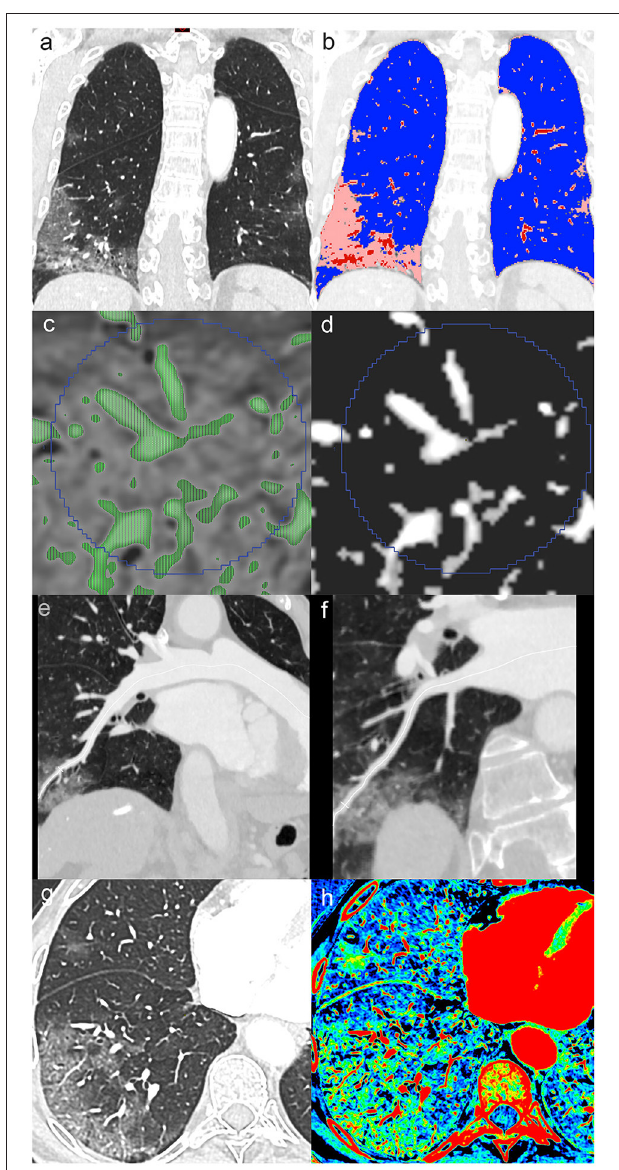
FIGURE 1 | Contrast-enhanced chest CT in a patient admitted for COVID-19. Coronal reformatted image (a) shows peripheral ground-glass opacity (GGO) predominantly involving the right lower lobe. Tissue classification (b) distinguishing alveolar opacity (peach color code) from normal parenchyma (blue) and vascular components (red) visually indicates vascular enlargement in COVID-19 pneumonia. Specific thresholds to isolate voxels, mostly containing vascular elements (c,d) , enable vascular volume extraction in regions-of-interest. Center-line reconstructions of the right posterior basal artery and vein (e,f) allow diameter measurement in GGO. Axial conventional image in lung window (g) with peripheral COVID-19-related GGO and corresponding dual-energy CT iodine density map (h) show increased iodine distribution in GGO consistent with hyperperfusion.